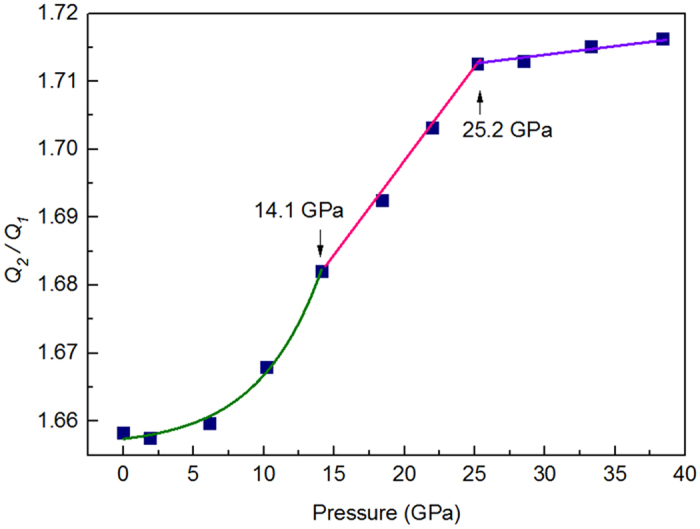
Q2/Q1 in the Yb62.5Zn15Mg17.5Cu5 metallic glass as a function of pressure.